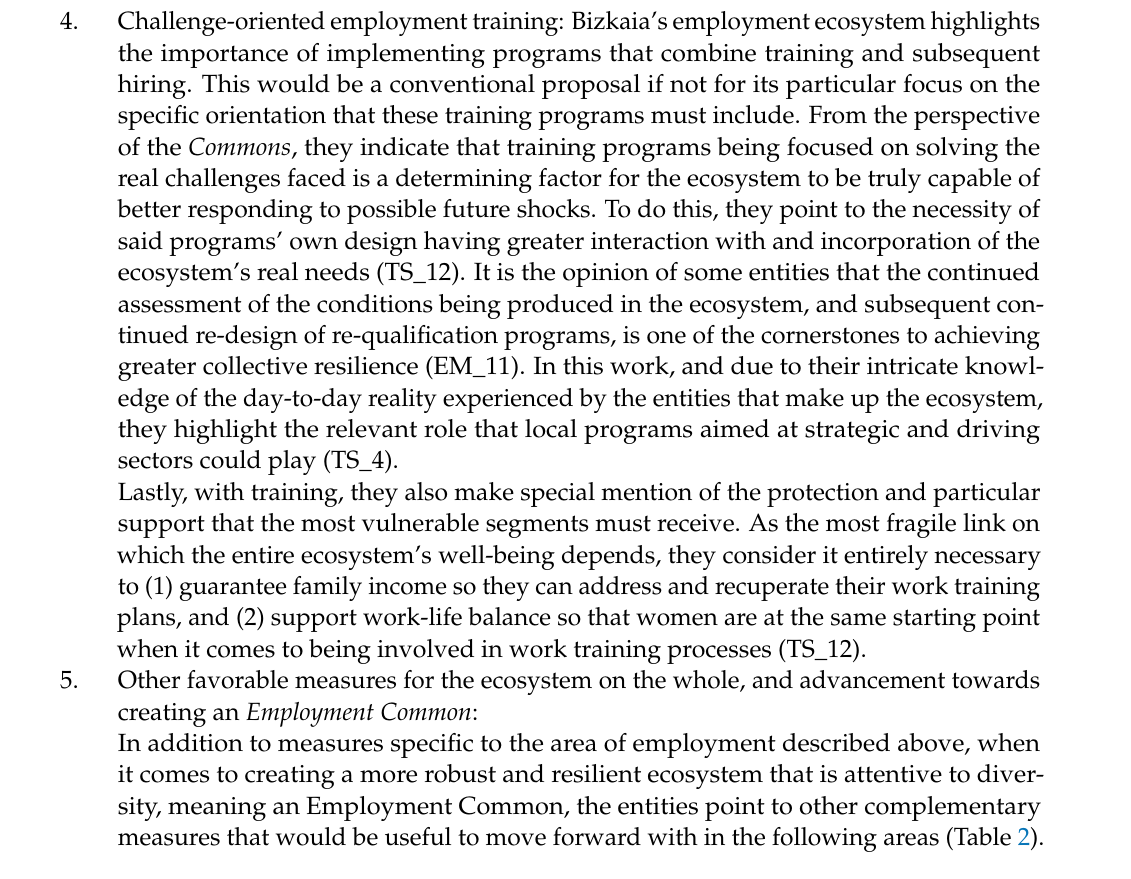
Table 2. Other favorable measures to advance towards an Employment